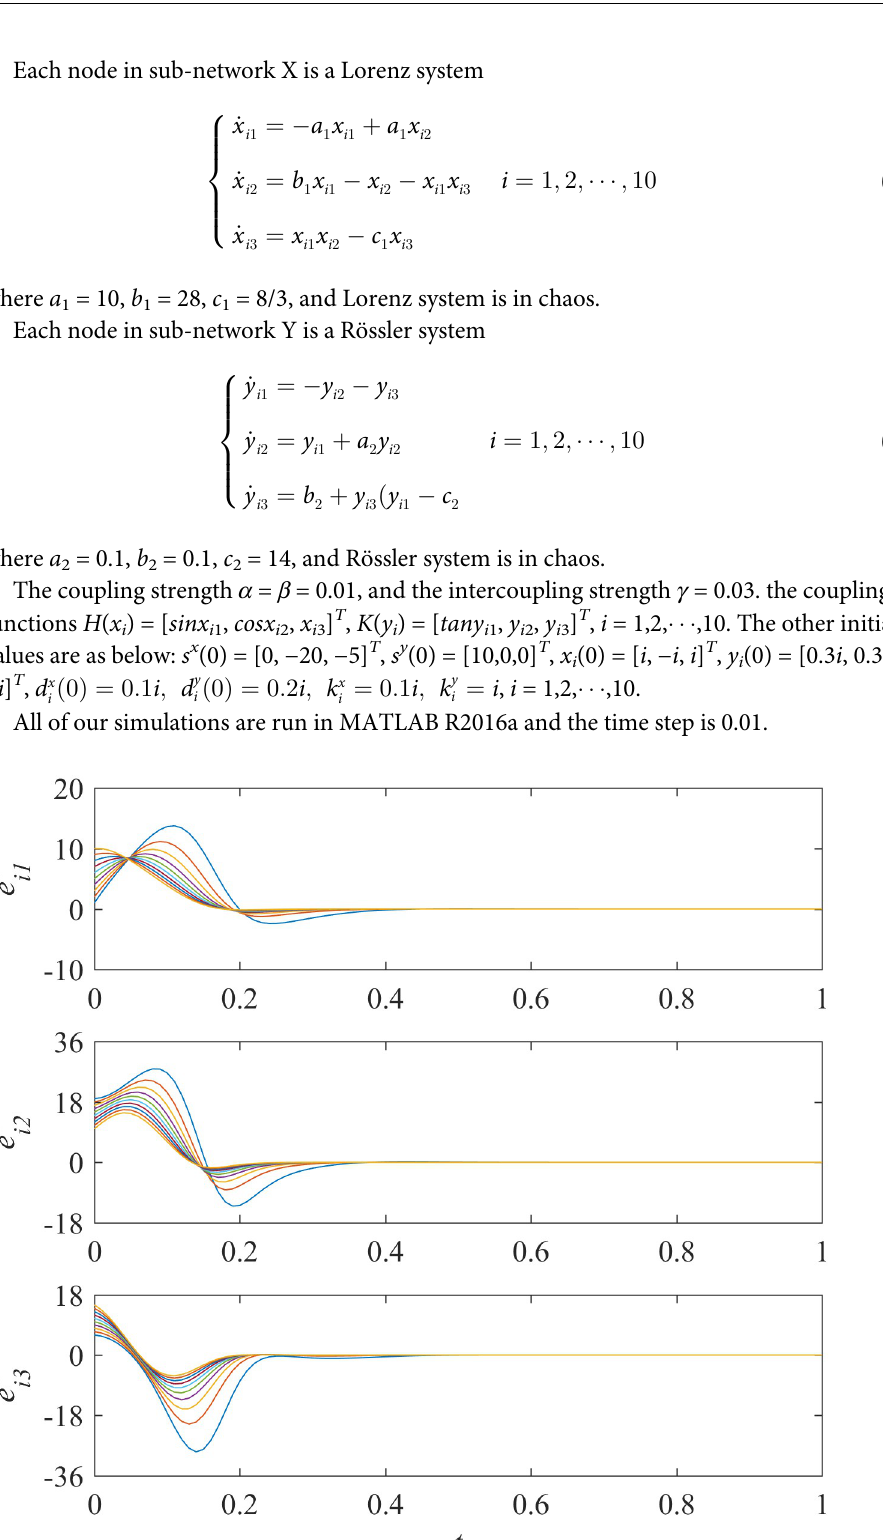
PLOS ONE | https://doi.org/10.1371/journal.pone.0267909 May 5,